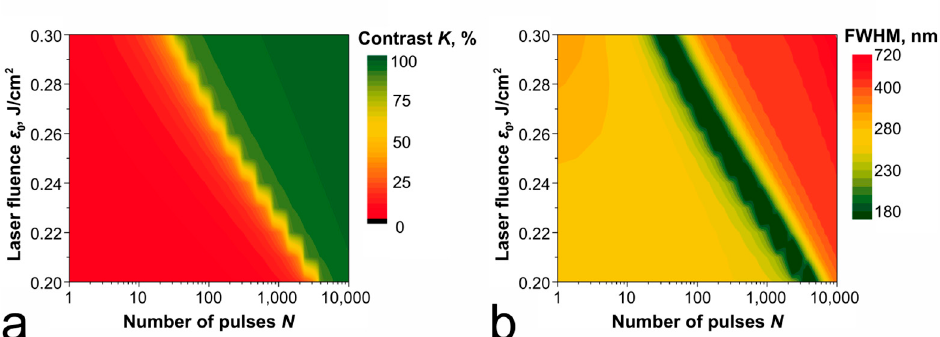
Figure 9. Estimated contrasts ( a ) and respective FWHMs ( b ) of the elements recorded under various conditions on a 60 nm-thick Ti film by a radiation with a wavelength λ = 532 nm .